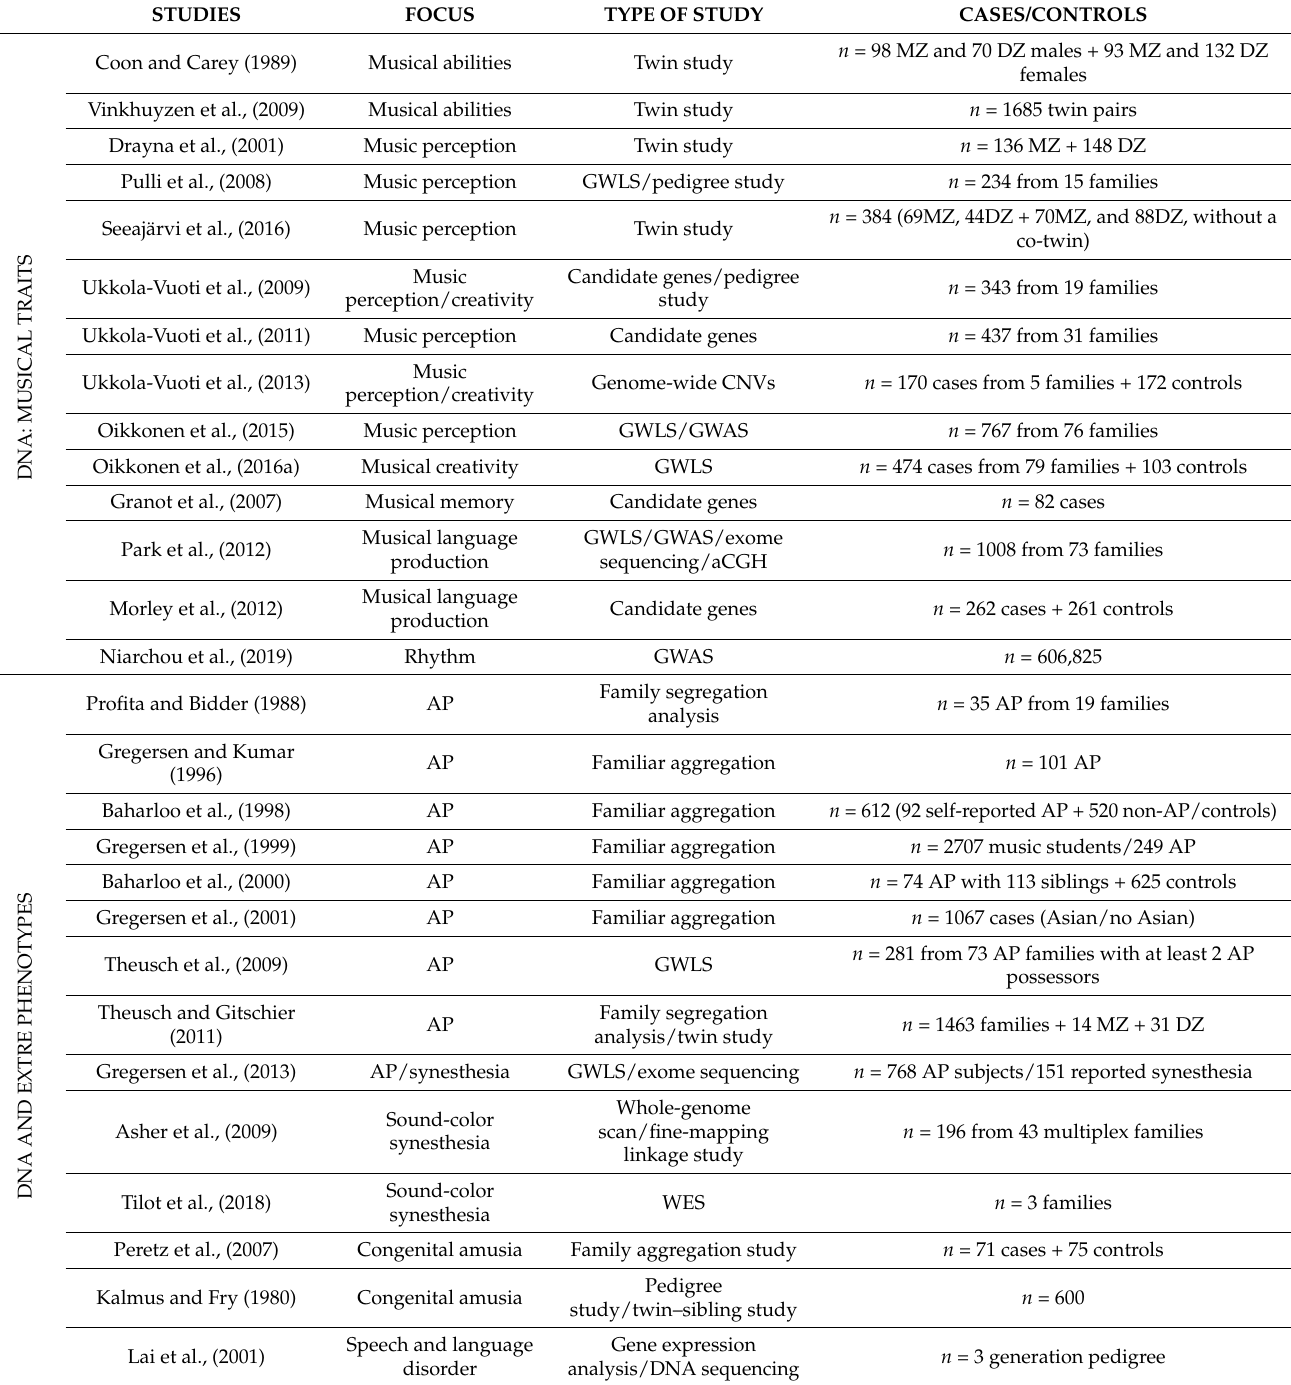
Table 1. Experimental genetic studies related to